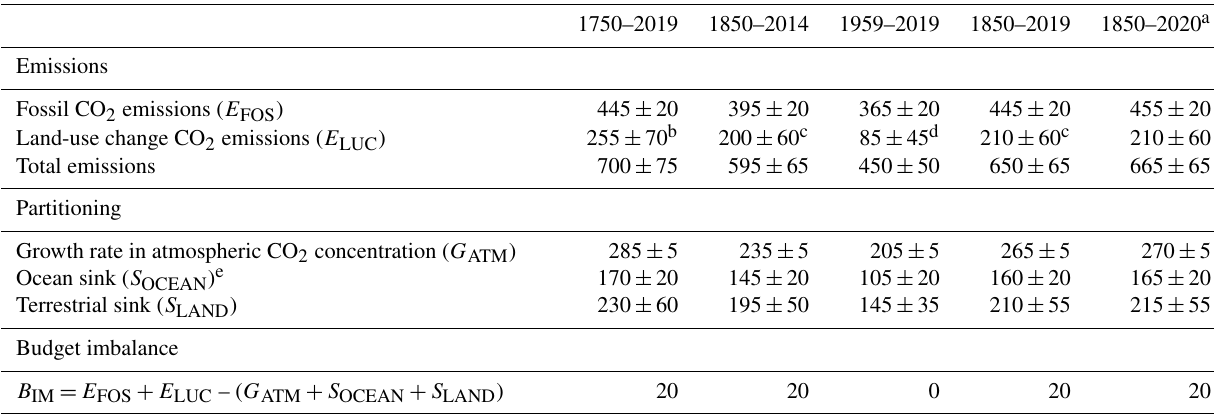
Table 8. Cumulative CO 2 for different time periods in gigatonnes of carbon (GtC). All uncertainties are reported as ± 1 σ . The budget imbalance provides a measure of the discrepancies among the nearly independent estimates. Its uncertainty exceeds ± 60GtC. The method used here does not capture the loss of additional sink capacity from reduced forest cover, which is about 20GtC and would exacerbate the budget imbalance (see Sect. 2.7.4). All values are rounded to the nearest 5GtC and therefore columns do not necessarily add to zero. Cement carbonation sink is included in E FOS